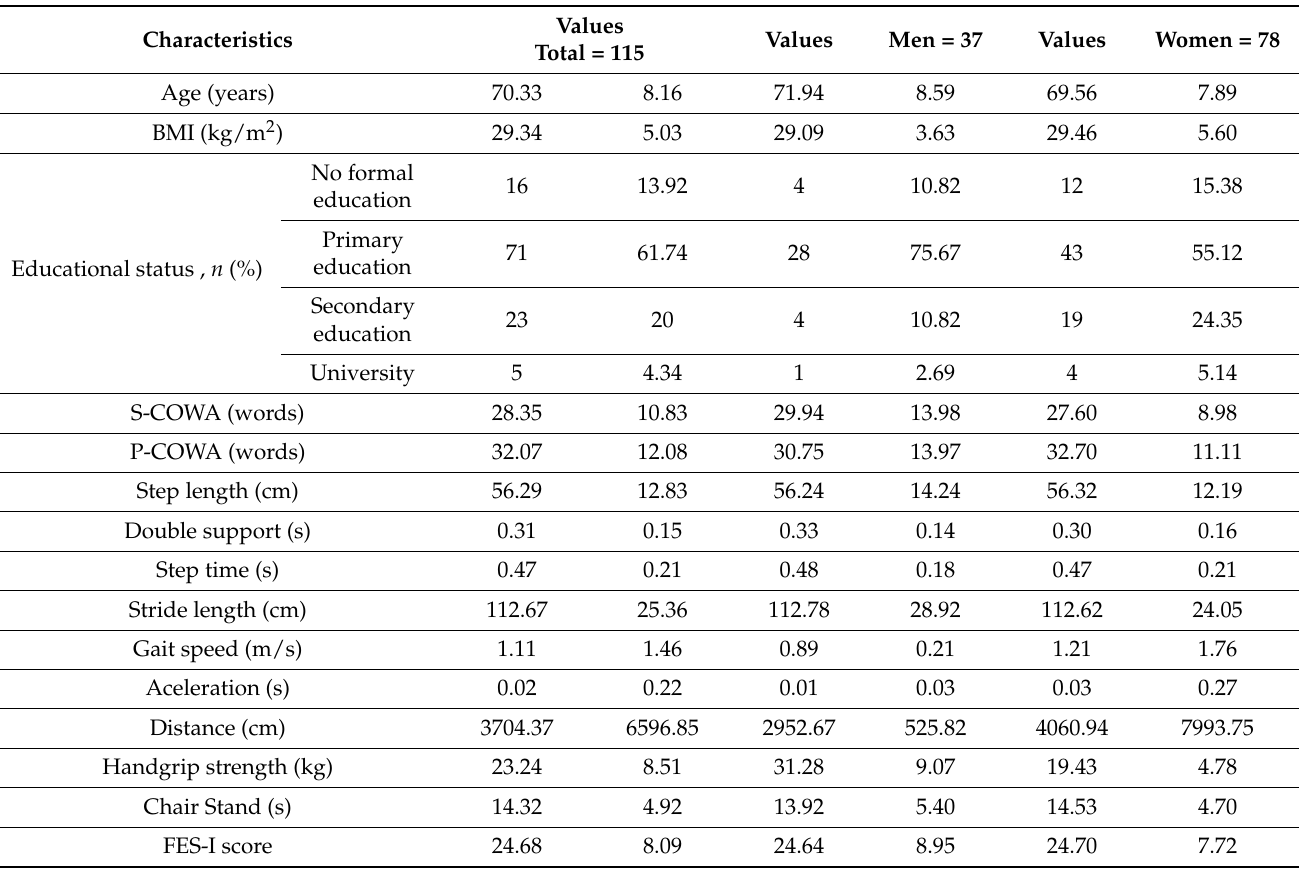
Table 1. Descriptive data of the sample ( n =